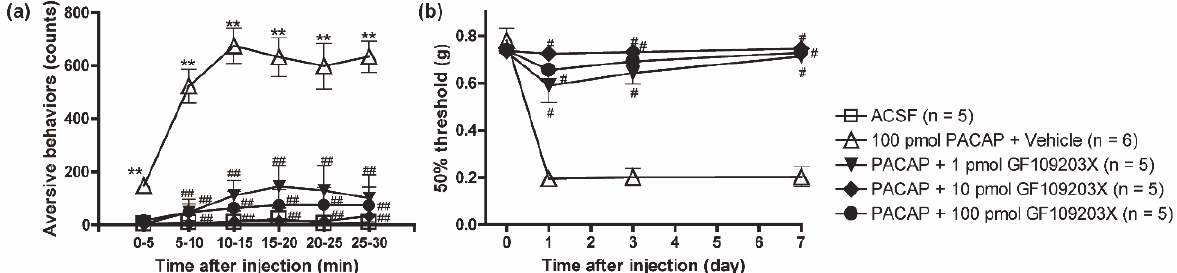
Figure 5. The importance of PKC in the PACAP/PAC1 receptor-induced nociceptive behaviors. Simultaneous intrathecal injection of GF109203X (1~100 pmol) with PACAP (100 pmol) dose-dependently reduced the PACAP-induced aversive behaviors ( a ) and mechanical allodynia ( b ). ** p < 0.01 when compared with ACSF data. # p < 0.05 and ## p < 0.01 when compared with PACAP + Vehicle data. Statistical significance was evaluated by the Tukey test for ( a ), and Steel test for ( b ).